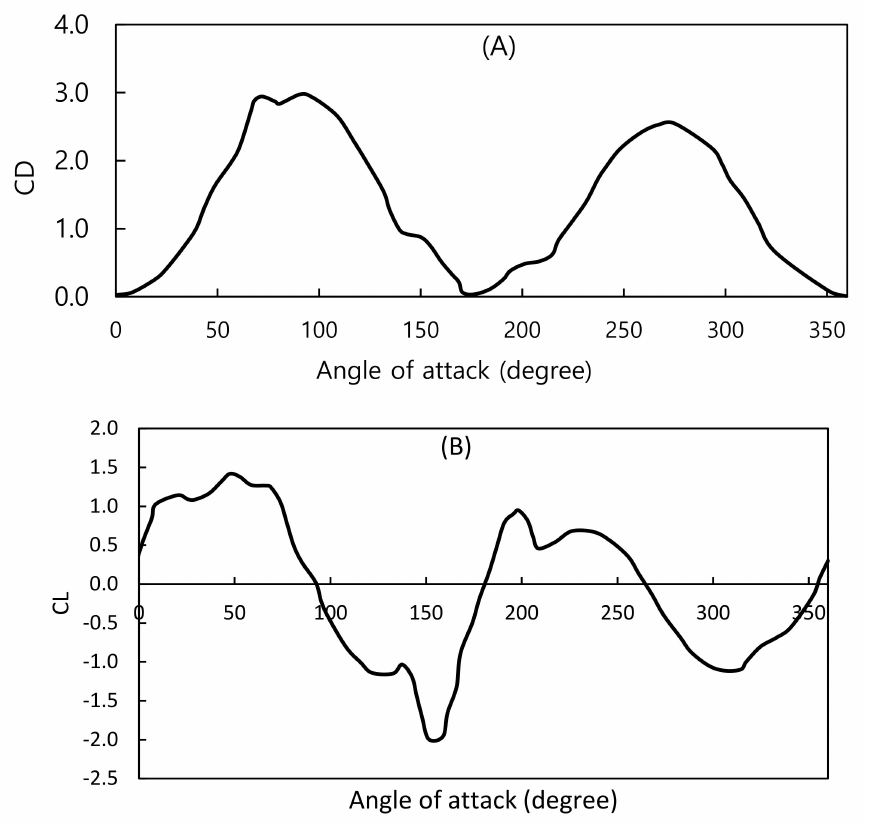
Figure 7. Aerodynamic characteristics of KA2 airfoil ( A ): Drag coefficient, ( B ): Lift coefficient at different angles of attacks.